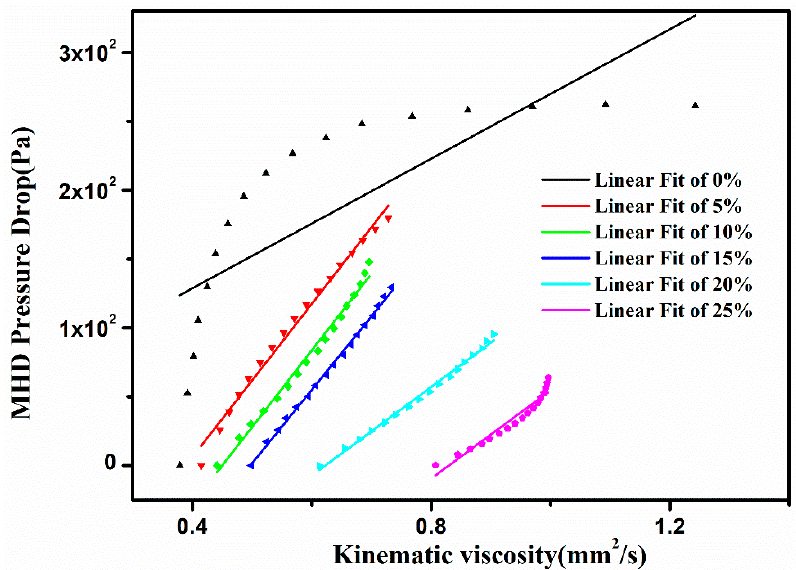
Figure 6. Relationship between magnetic fluid pressure drop ∆ P MHD and kinematic viscosity η under different volume fractions. Table 2. Parameters related to fitting curve of magnetic fluid pressure drop △ 𝑃 (cid:3014)(cid:3009)(cid:3005) and kinematic viscosity η .